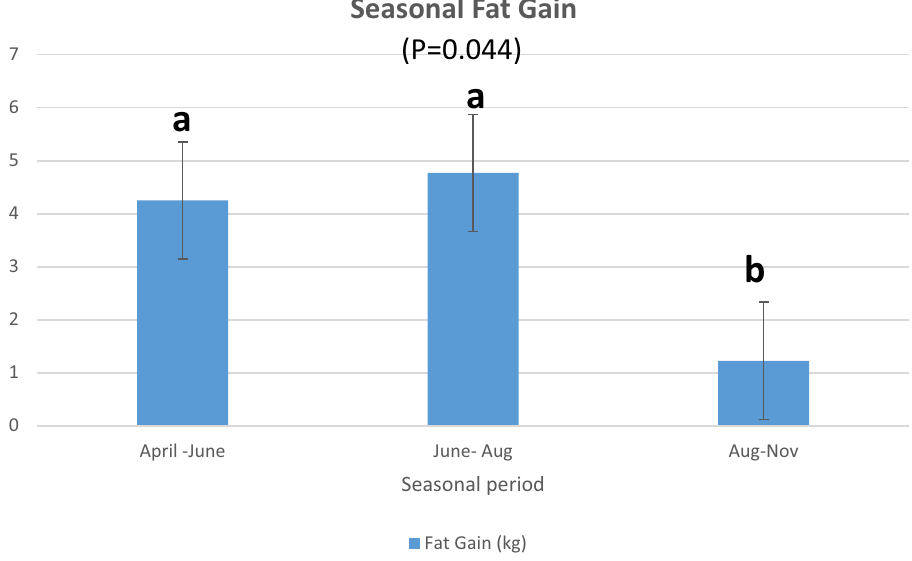
Figure 2. Seasonal variation in emu back and abdominal fat weight gain.